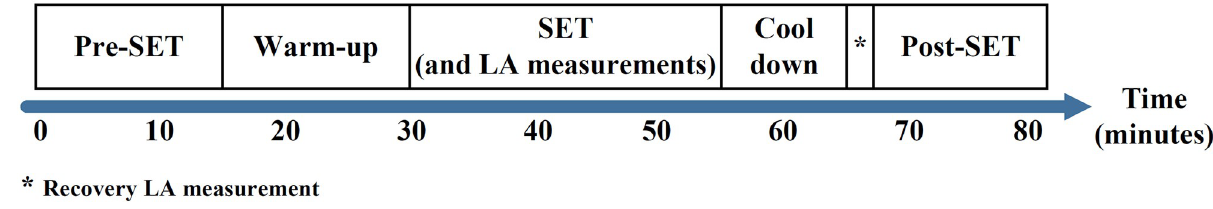
Fig 2. Order of the tasks for horses to perform a